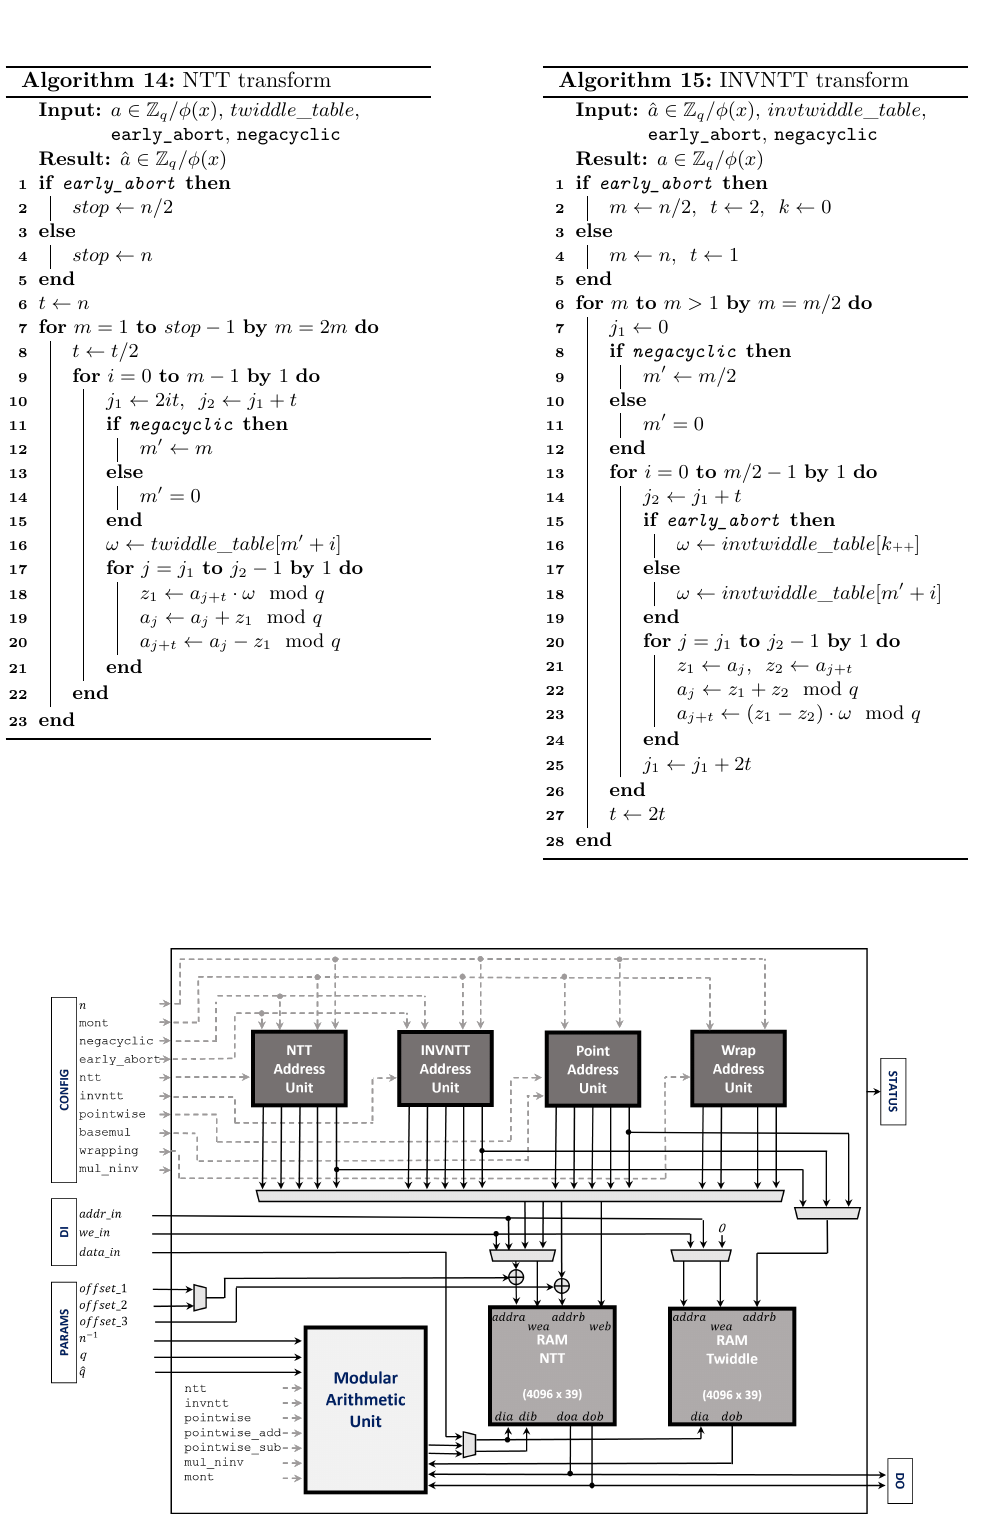
Figure 5: Loosely coupled NTT Unit (dashed lines for configuration